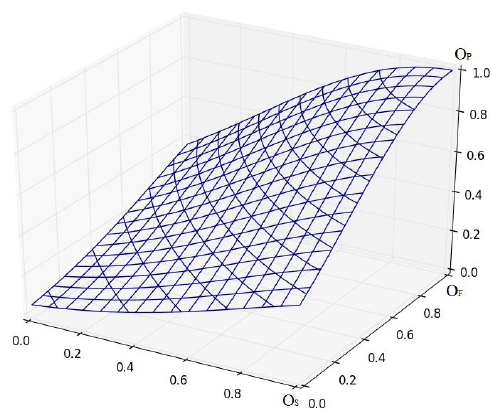
Figure 3. Graphic interpretation of aggregated estimation.